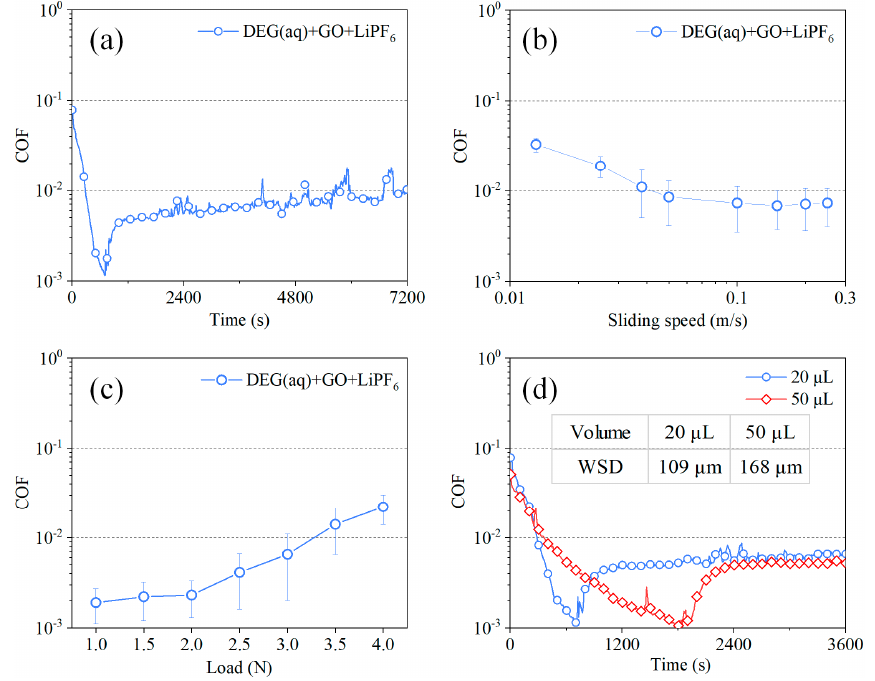
Figure 4. COFs of GO and LiPF 6 containing DEG(aq) under various conditions, ( a ) long run (3 N, 100 mm/s, and 20 µ L), ( b ) sliding speed (3 N and 20 µ L), ( c ) normal load (100 mm/s and 20 µ L), and ( d ) solution volume (3 N and 100 mm/s).